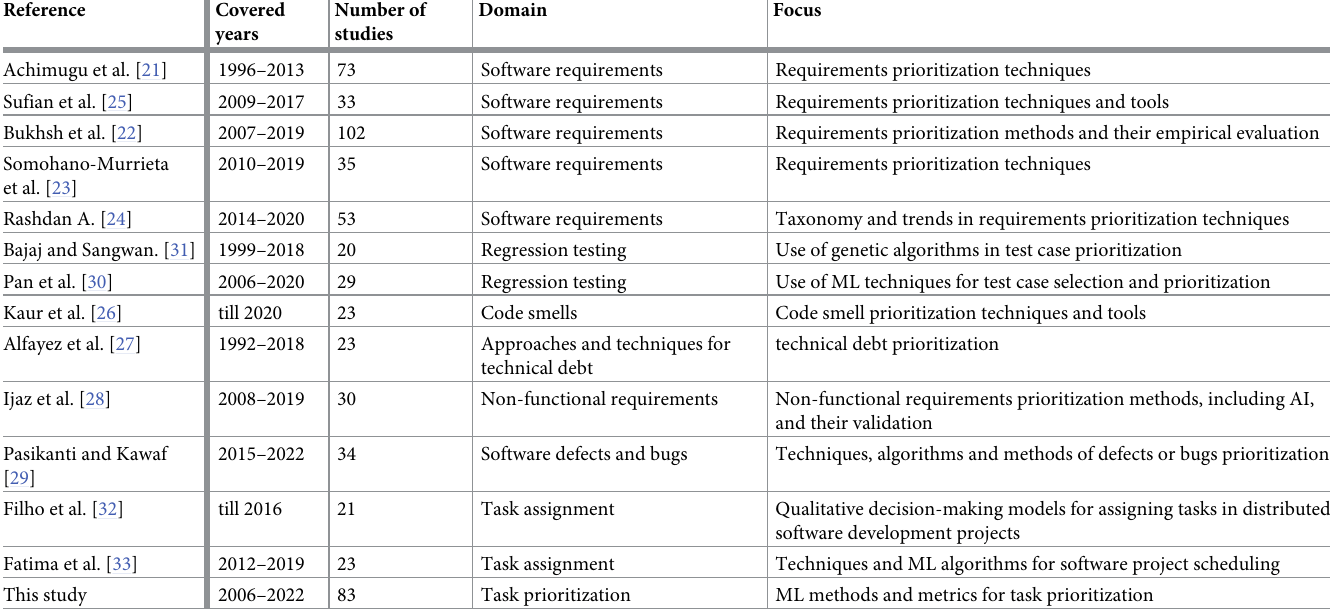
Table 1. Summary of existing related literature